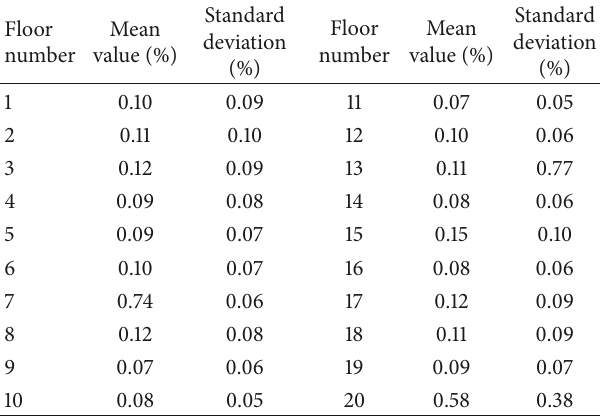
Table 5: The mean value and standard deviation of errors for the estimated wind load with − 5% error in natural frequencies.